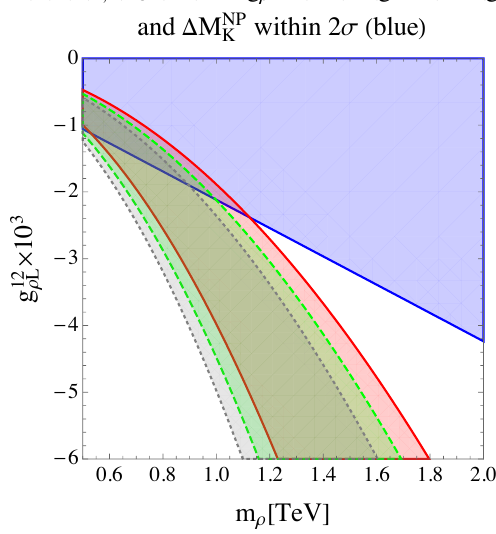
Figure 5 . The (cid:1) M NP values of g (cid:26)